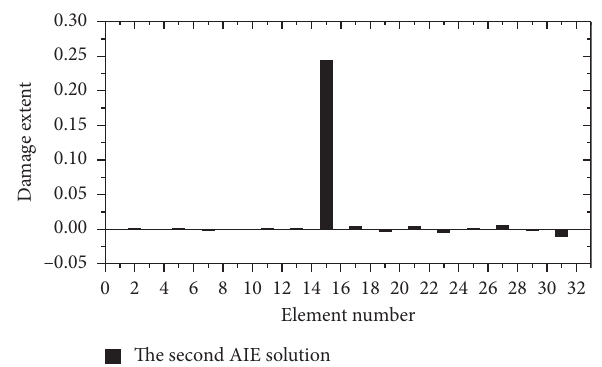
Figure 4: Damage assessment result by the second AIE when element 15 is